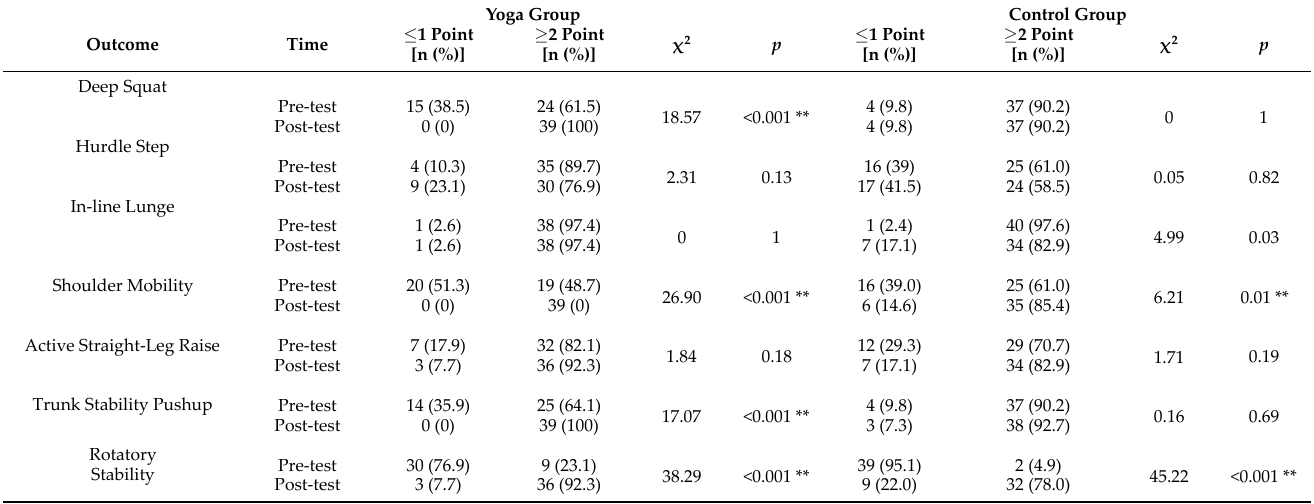
Table 6. The yoga group’s FMS dysfunctional scores ratio at pre‑ and post‑test for the two groups.